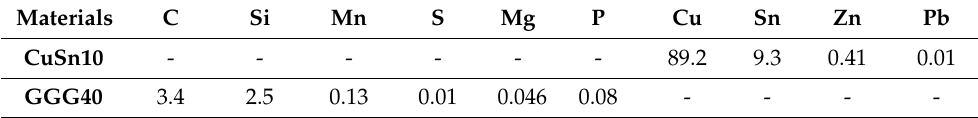
Table 1. Chemical composition of the matrix and reinforcement materials at wt% [1].